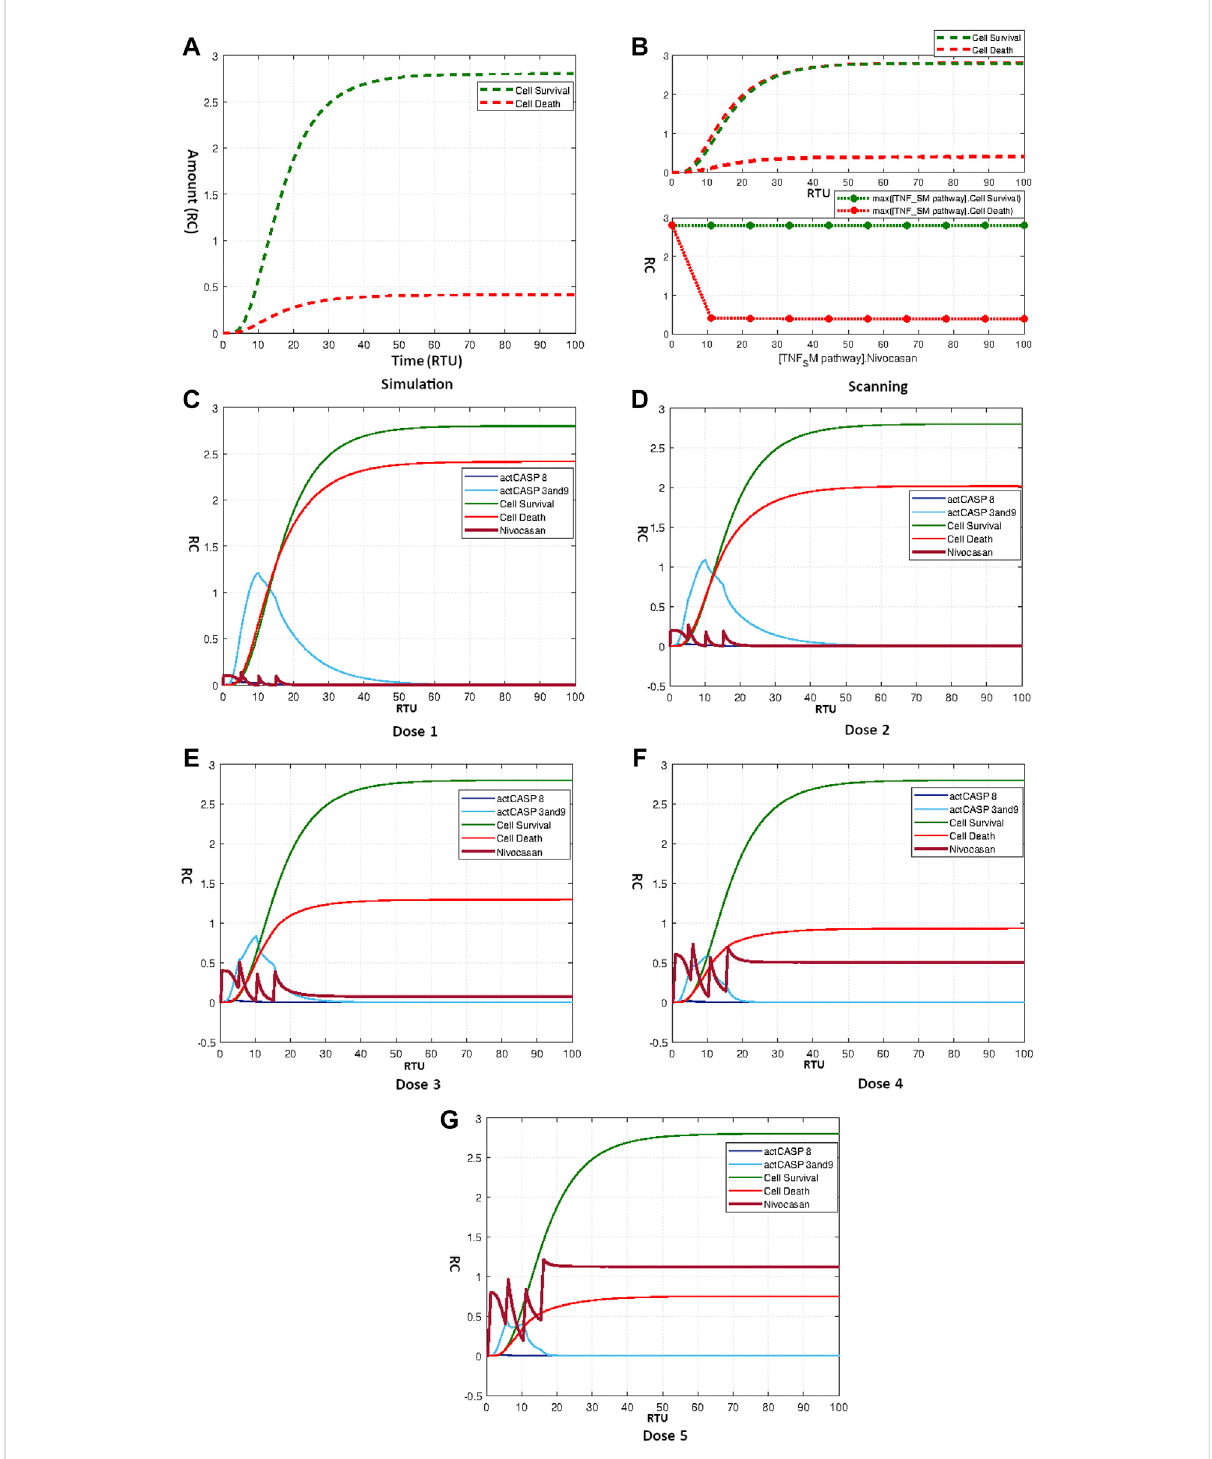
FIGURE 10 (A) Simulation showing effect of Nivocasan on Neuronal Survival and Death. (B) Scanning of Nivocasan. (C – G) Figures c to g represent the dosage graphs for the Nivocasan as according to Table 4. Dosages (C – G) show obvious effect on neuronal